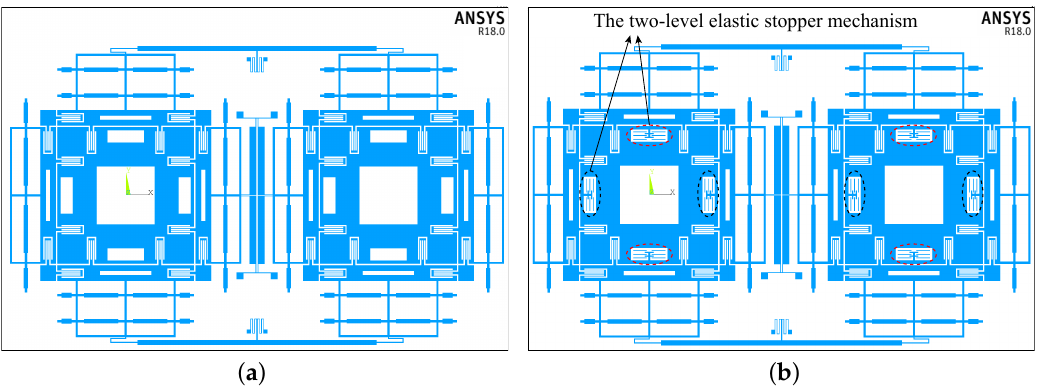
Figure 11. The structure model for FE simulation: ( a ) The structure without stopper mechanism. ( b ) The structure with the two-stage elastic stopper mechanism.